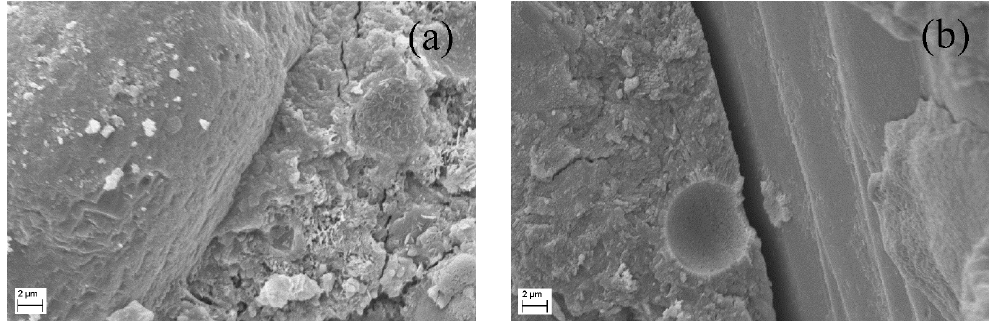
Figure 15. Scanning electron microscopy (SEM) images of interfacial transition zone between aggregate and cement paste: ( a ) RFA and ( b ) NFA.